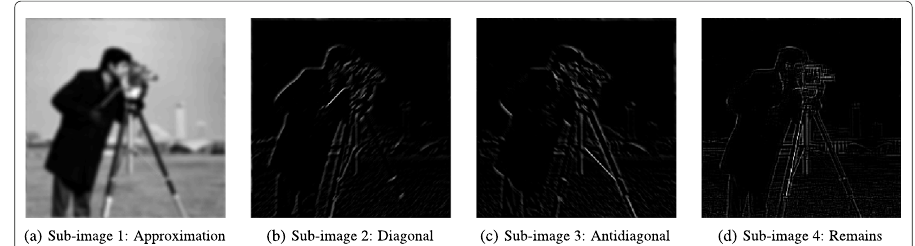
Fig. 13 Sub-images1–4 of the “Cameraman” image processed with the “ SSA-iSBD4-channelfilterbank ,” type “ diagonal/antidiagonal ,” with L =